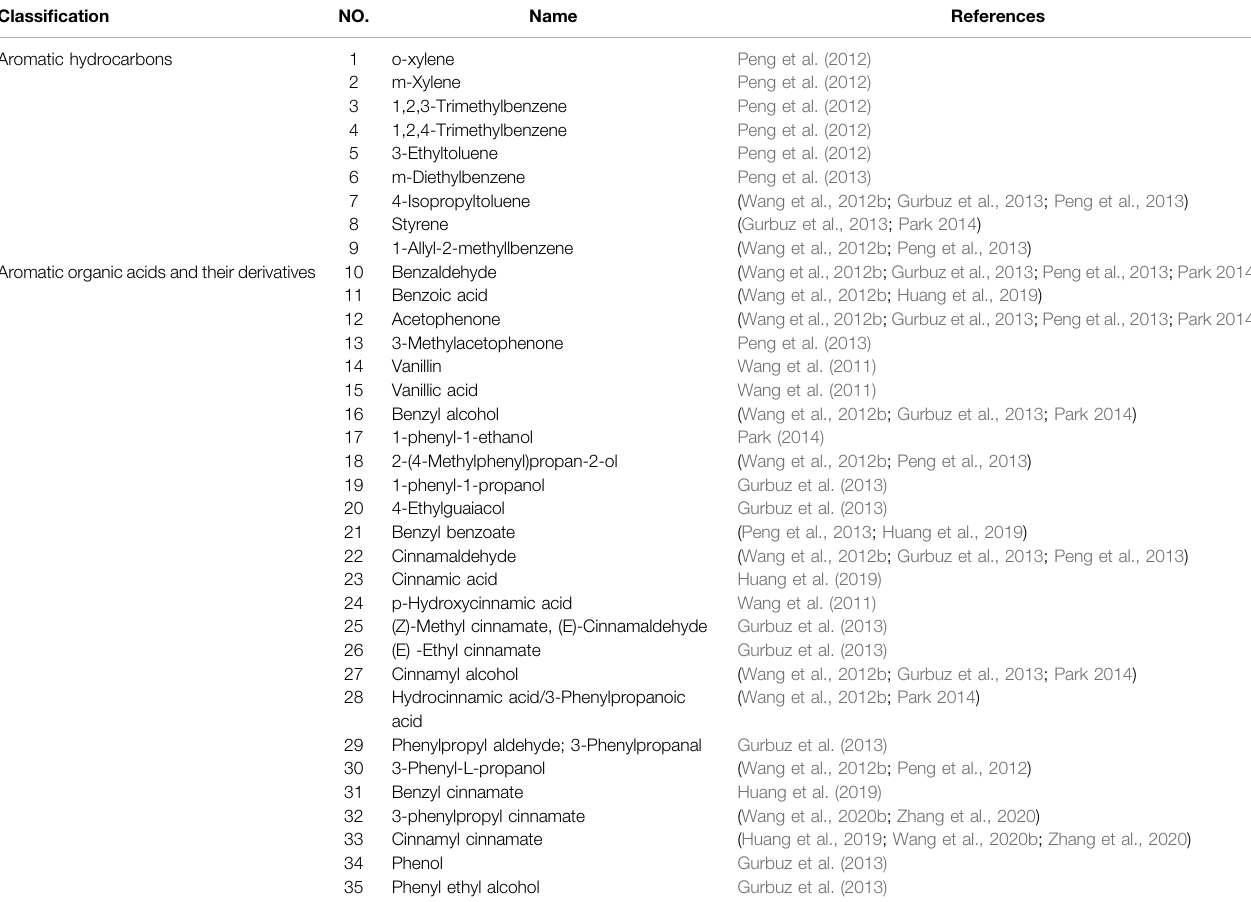
TABLE 1 | Chemical constituents of aromatic compounds from Storax. Classi fi cation